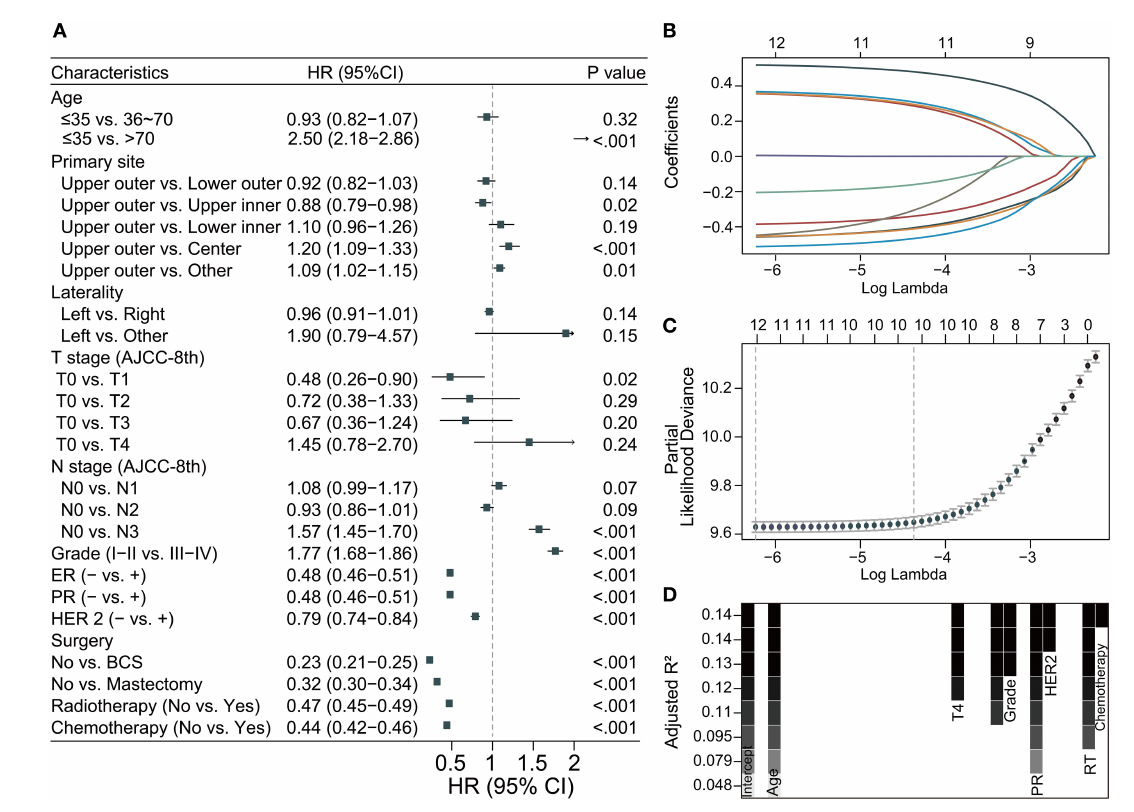
FIGURE3 Predictor screening. (A) Univariate Cox regression; (B,C) the least absolute shrinkage and selection operator (LASSO) regression and 5-fold cross-validation; (D) best subset regression (BSR). ER, estrogen receptor; PR, progesterone receptor; HER 2, human epidermal growth factor receptor 2; BCS, breast conservation surgery; HR, hazard ratio; 95% CI, 95% confidence interval; RT, radiation